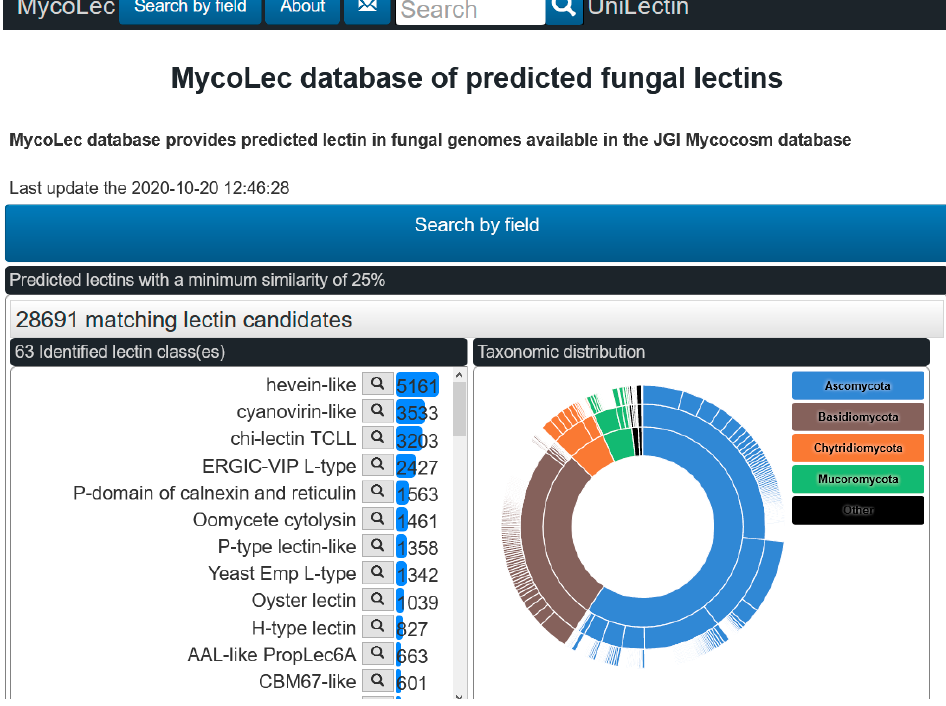
Figure 2. Access page of the MycoLec database with information about the distribution of fungal lectins as a function of classes and as a function of the fungal taxonomy.